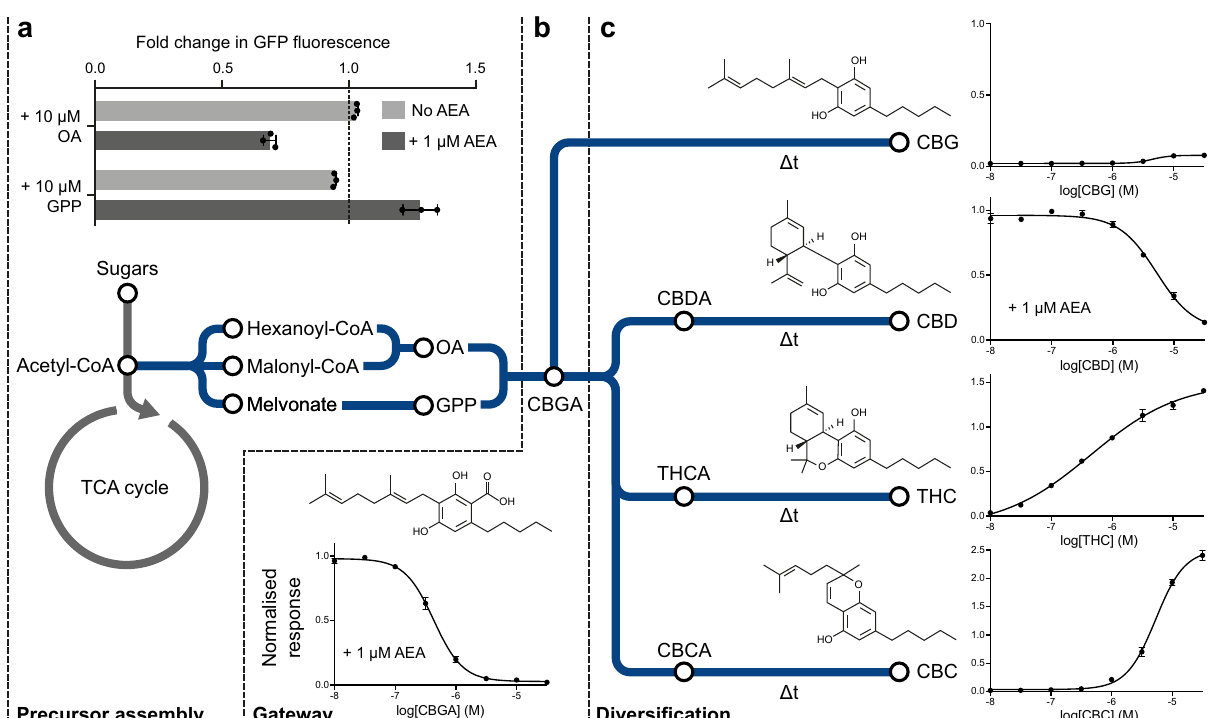
Fig.2|Sensingcannabinoidsandtheirprecursors.a – c Metabolicpathwayforthe complete biosynthesis of cannabinoids in yeast from sugar feedstocks, as demon- strated in Luo et al. 9 . a Fold change in CB2 biosensor expression after addition of 10 µ M olivetolic acid (OA) and geranyl pyrophosphate (GPP) in the presence (dark grey) and absence (light grey) of 1 µ M anandamide (AEA). b Cannabigerolic acid (CBGA) dose-response curve in the presence of 1 µ M AEA with the CB2 biosensor. c Cannabigerol (CBG), cannabidiol (CBD), Δ 9 -tetrahydrocannabinol (THC), and